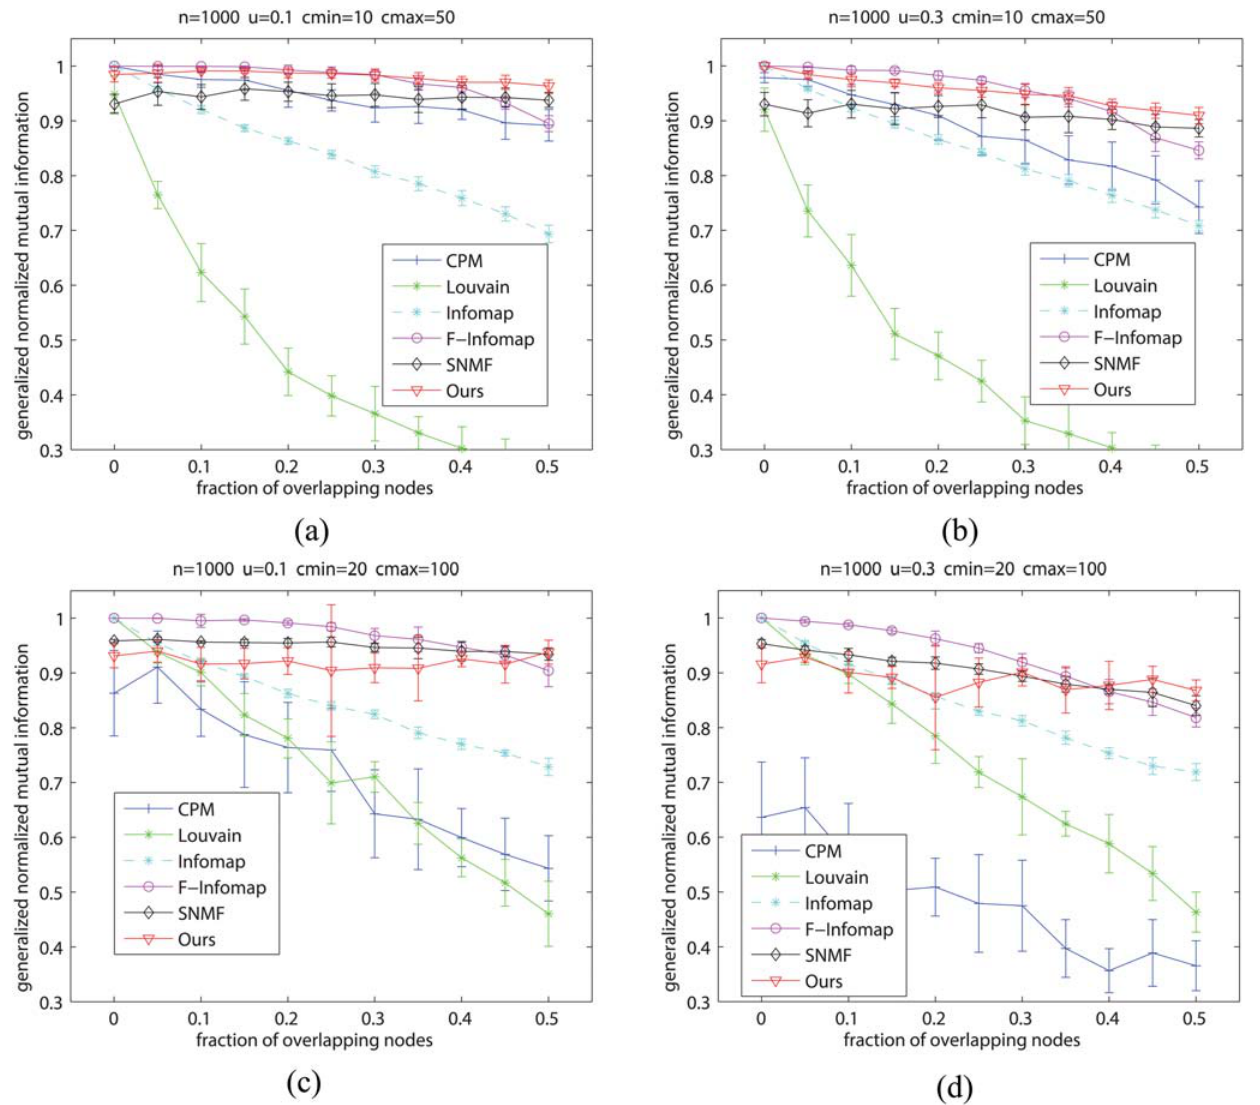
Fig 4. Evaluation of different methods on LFR benchmark networks. (a) Comparison on LFR networks with small mixing parameter and small communities; (b) Comparison on LFR networks with large mixing parameter and small communities; (c) Comparison on LFR networks with small mixing parameter and large communities; (d) Comparison on LFR networks with large mixing parameter and large